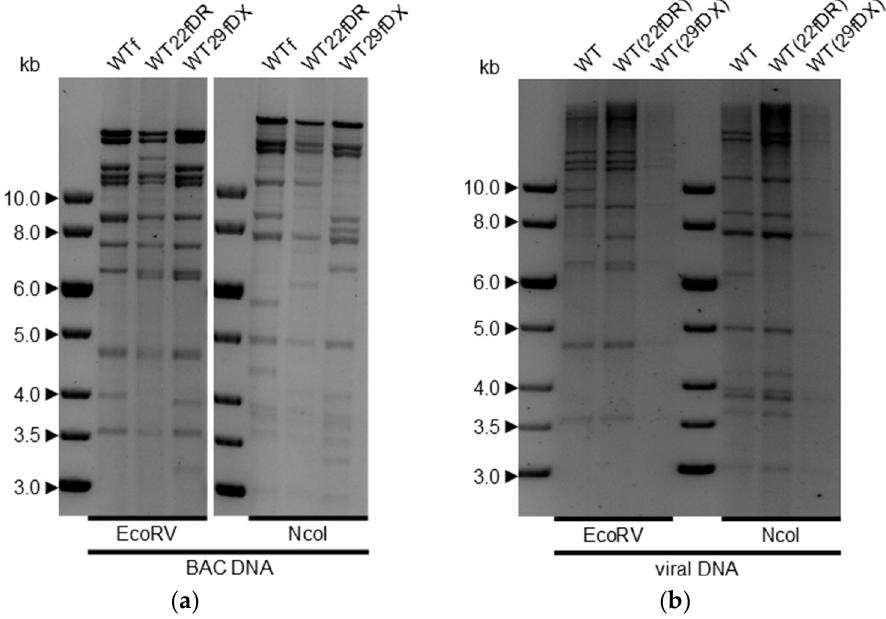
Figure 3. Restriction-fragment length polymorphism analysis (RFLP) of isolated HVS C488 variant DNA subjected to restriction digestion with enzymes EcoRV and NcoI, respectively. The DNA fragments were separated on a 0.7% agarose gel. Gray shades are displayed inversely. ( a ) BAC DNA of the varying wild-type-like virus variants with miniF located in ORF14 (WTf), ORF22 (WT22fDR) and ORF29 (WT29fDX), respectively. ( b ) Viral DNA isolated after nine passages in OMK cells compared to the wild-type virus HVS C488. Self-repair was reliably completed at that passage and the miniF sequence removed from the viral genome.